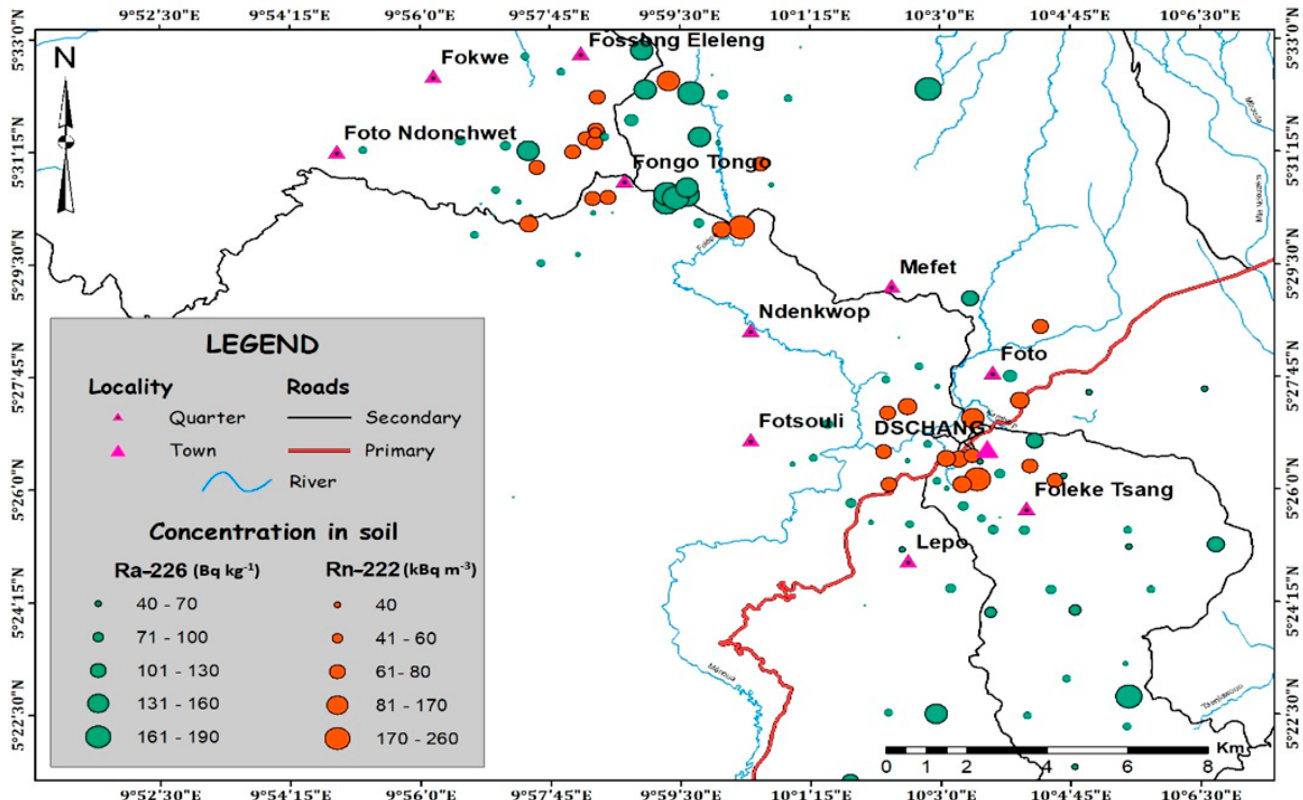
Figure 5. Map distribution of 222 Rn and 226 Ra concentrations in the soil of the study area.